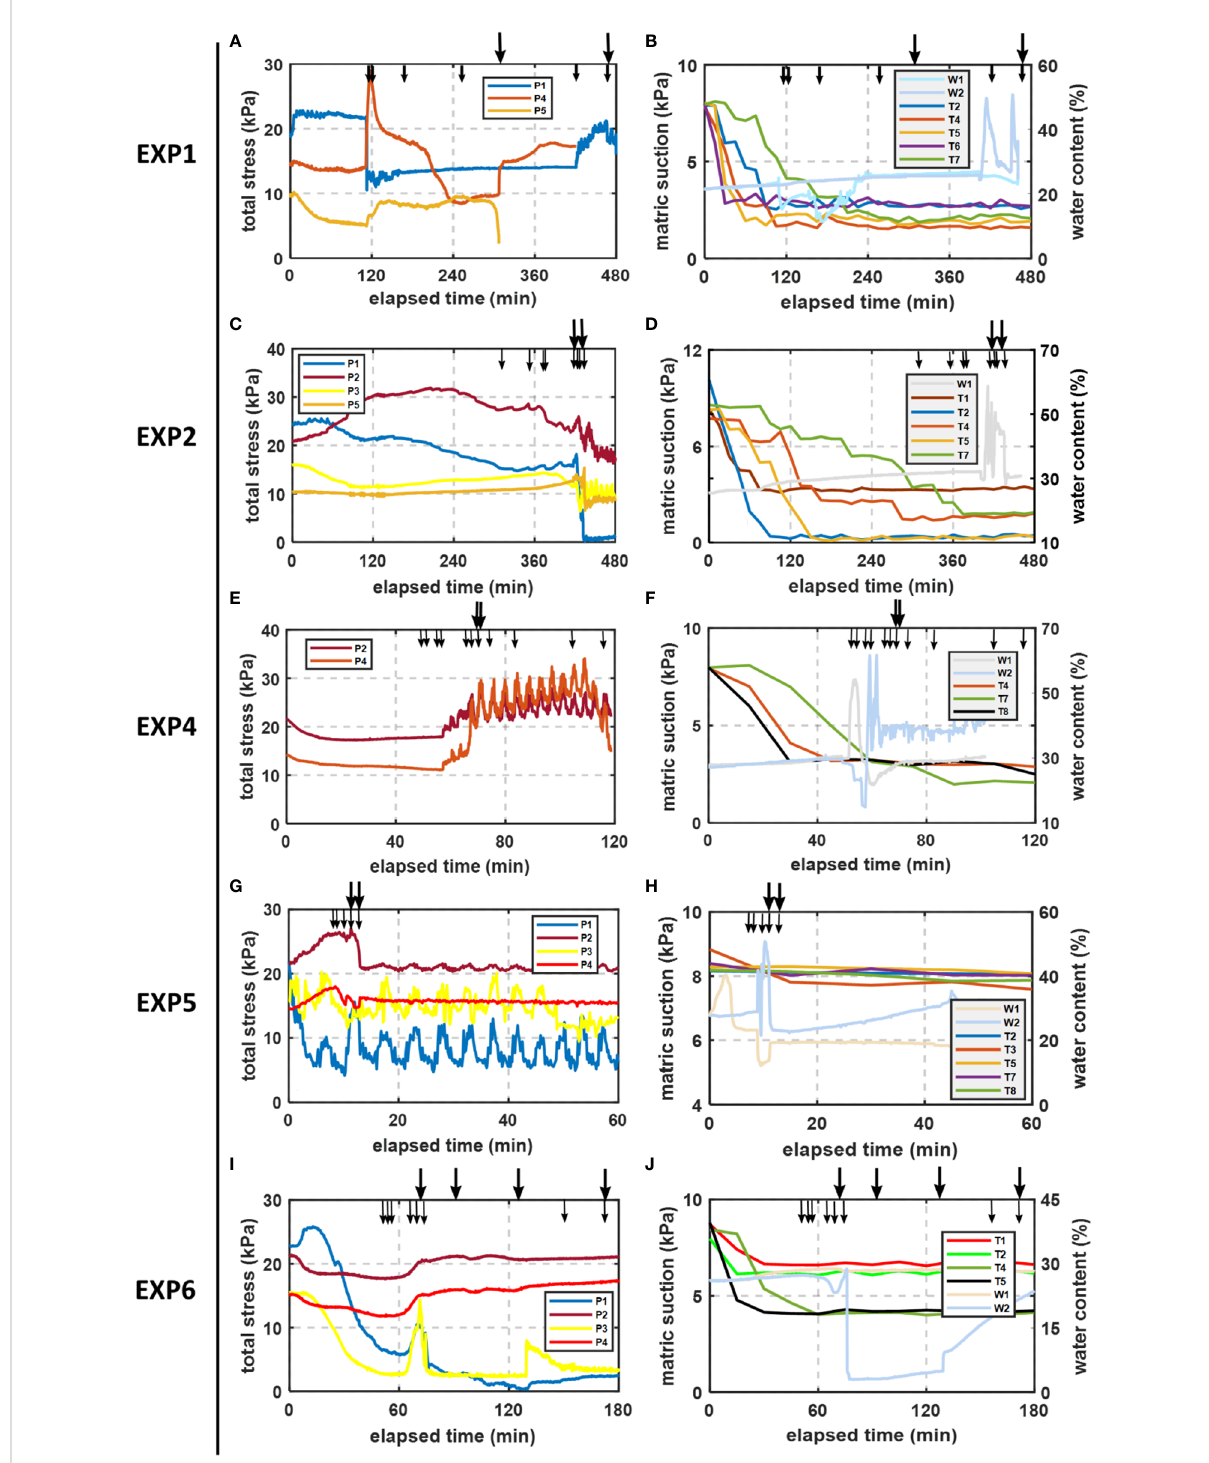
FIGURE 6 Temporal evolution of soil total stress, matric suction, and water content: (A) total stress in EXP 1; (B) matric suction and water content in EXP 1; (C) total stress in EXP 2; (D) matric suction and water content in EXP 2; (E) total stress in EXP 4; (F) matric suction and water content in EXP 4; (G) total stress in EXP 5; (H) matric suction and water content in EXP 5; (I) total stress in EXP 6; (J) matric suction and water content in EXP 6. Arrows indicate the occurrence of bank failure: large arrows represent toppling failure whereas the small arrows indicate seepage erosion, tensile, and shear failures. P, soil stress sensor; W, soil moisture sensor; T, tensiometer. Position of sensors can be found in Figure 2 and Table